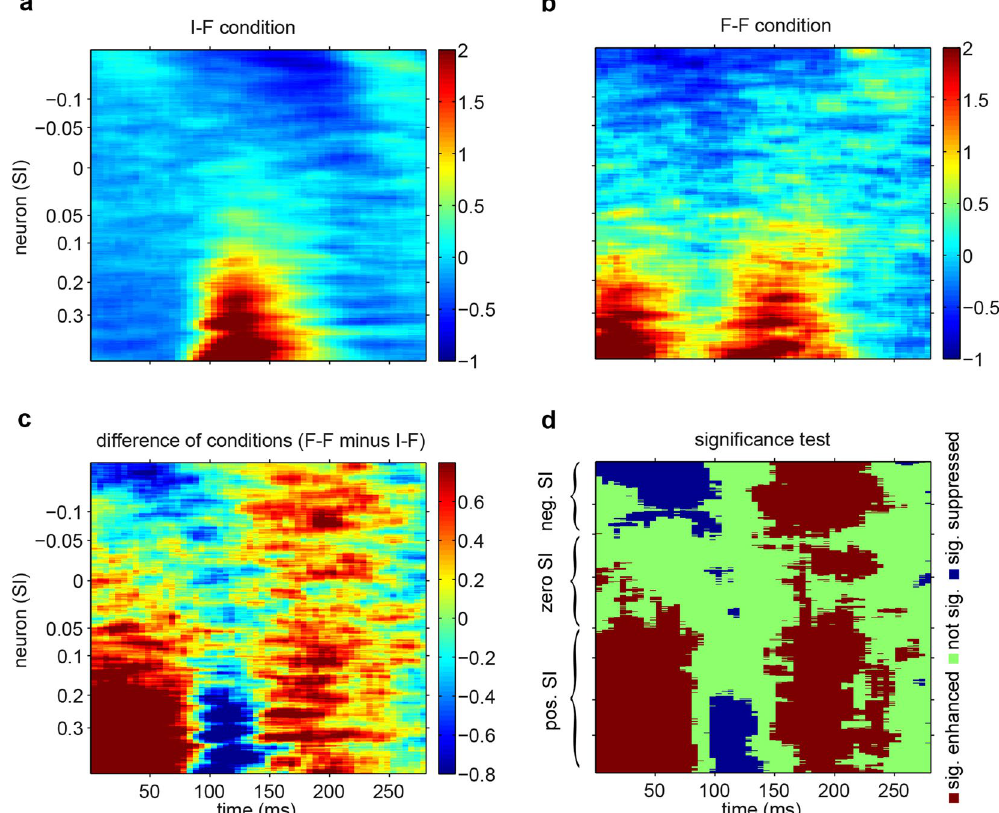
Figure 1. Effects of rapid face adaptation on the activity of a population of IT neurons. In ( a–d ) graphs, each row represents a neuron, which are sorted in the order of the selectivity index (SI) of the neurons, and the abscissa represents time from stimulus onset. ( a–c ) The graphs indicate the z-scored response under ( a ) the I-F condition, ( b ) the F-F condition, and ( c ) F-F minus I-F across all 674 neurons. All ( a–c ) graphs were vertically smoothed by a sliding window of 21 neurons, and the color scheme next to each graph represents the z-scored responses. ( d ) Indicates the significance test for differences across subpopulations with a sliding window of 51 neurons (paired t-test). Blue, red, and green represent significant suppression, significant enhancement, and non-significant differences, respectively, under the F-F condition compared to the I-F condition. The threshold for the p-values in ( d ) are FDR corrected for multiple comparisons. Three groupings of neurons based on their SI (pos. SI, zero SI, and neg. SI) are indicated on the vertical axis of ( d